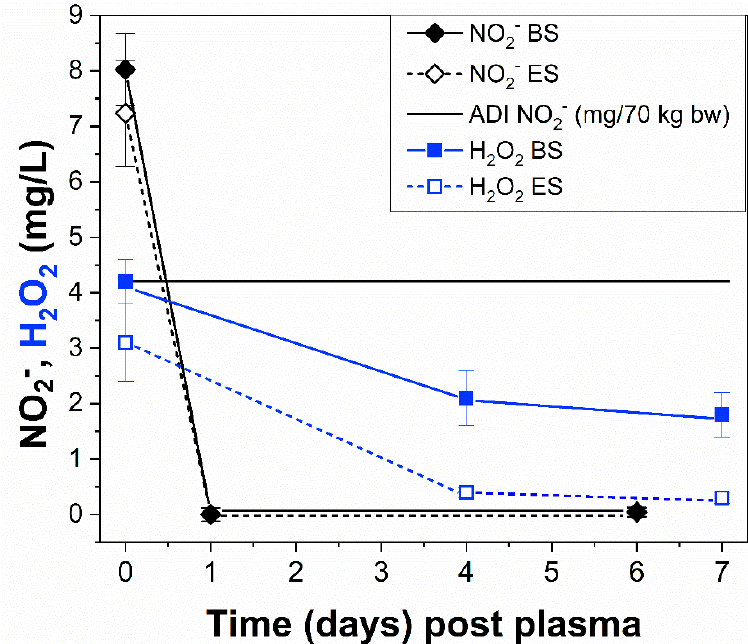
Figure 2. NO 2 − and H 2 O 2 concentrations (mean ± SD, n = 3) that was measured in the air-transient- spark-treated fresh apple juice compared to the ADI dose (NO 2 − ), which was calculated for a human with a 70 kg body weight. The shown measured and ADI values are directly comparable assuming the daily consumption of 1 L of the juice per person.